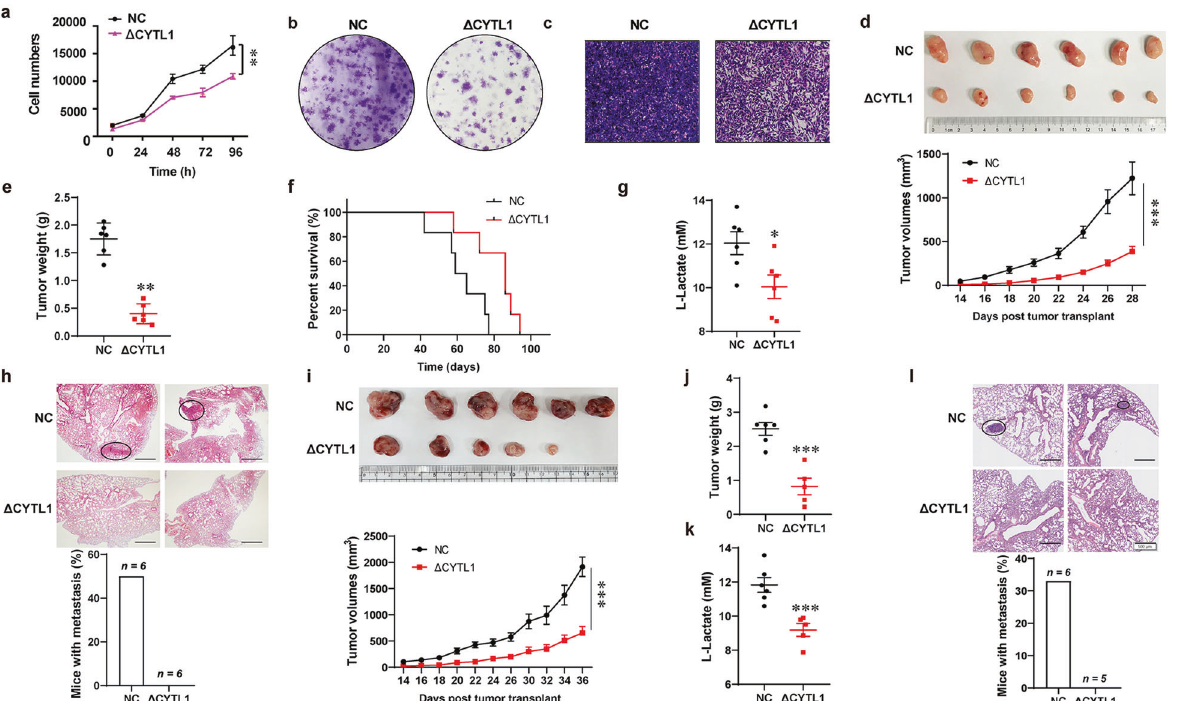
expressing Δ CYTL1 were cultured for 15 days. c Cell migration of MDA-MB-231 cells expressing Δ CYTL1 was determined using transwell assay. d – h Female nude mice were subjected to orthotopic injection with MDA-MB-231 cells stably expressing Δ CYTL1. Some mice were sacri fi ced 28 days later, after which tumors, lungs, and sera were collected, followed by photography and measurement. Some mice were monitored until they died. d Tumor growth curves ( n = 6). Upper panel: representative images of the tumors at the end of the experiments. e Tumor weight. f Survival curve of mice ( n = 6). g Serum lactate levels. h Representative H&E-stained lung sections. Circles indicate metastatic foci in the lungs. Scale bar, 500 μ m. Lower panel: the proportion of mice with lung metastases in each group. i – l Female C57BL/6 mice